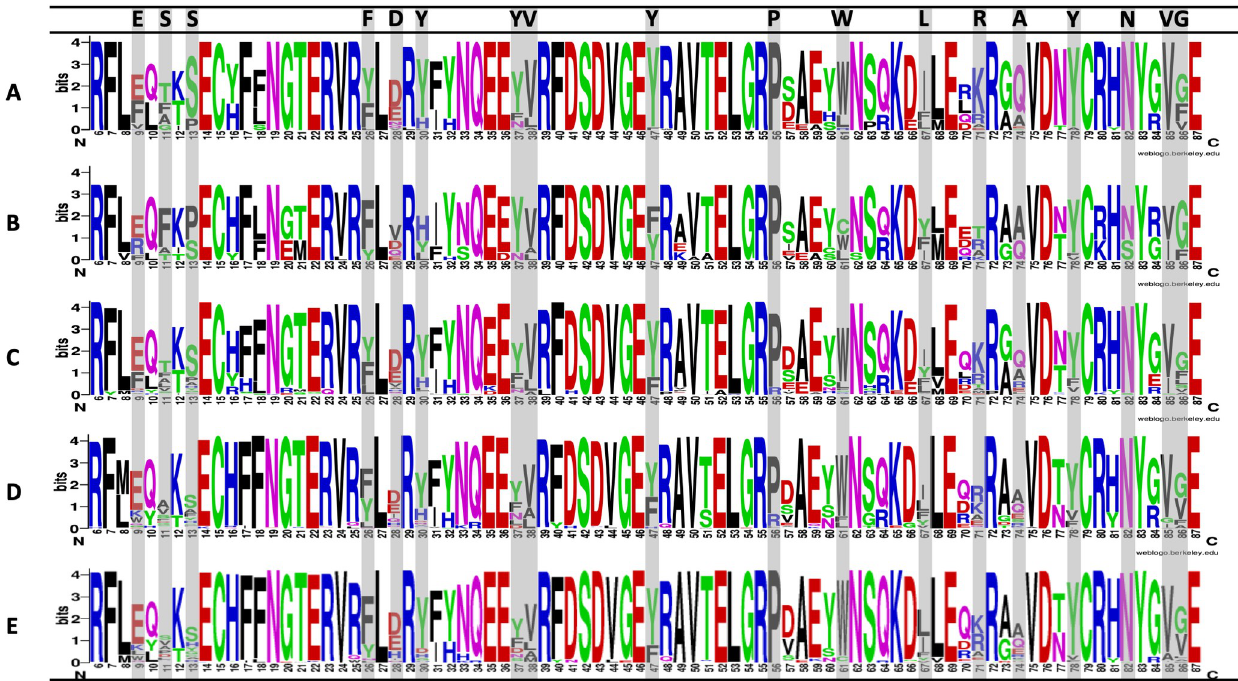
Fig 5. Graphical representation of the sequence conservation of amino acids (sequence logo) for DRB exon 2. Compares site variability between Cebus (A), Sapajus (B), Platyrrhini (C), Cercopithecoidea (D) and Hominoidea (E). Single letter codes are shown for amino acids and colors indicate their major biochemical properties: Red–acidic; Blue–basic; Green–polar; Black–hydrophobic. Generated using WebLogo [84]. Gray shading indicates predicted PBR (peptide binding region) sites based on human PBR in [39]. Letters in the top row indicate the most common amino acid at that site in human HLA alleles